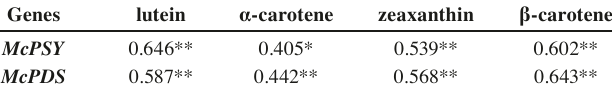
Tab. 5: Correlation coefficients (R) exhibiting relationship between the ex - pression of two evaluated genes (PSY and PDS) and the measured related carotenoids (lutein, α-c arotene, zeaxanthin, and β-c